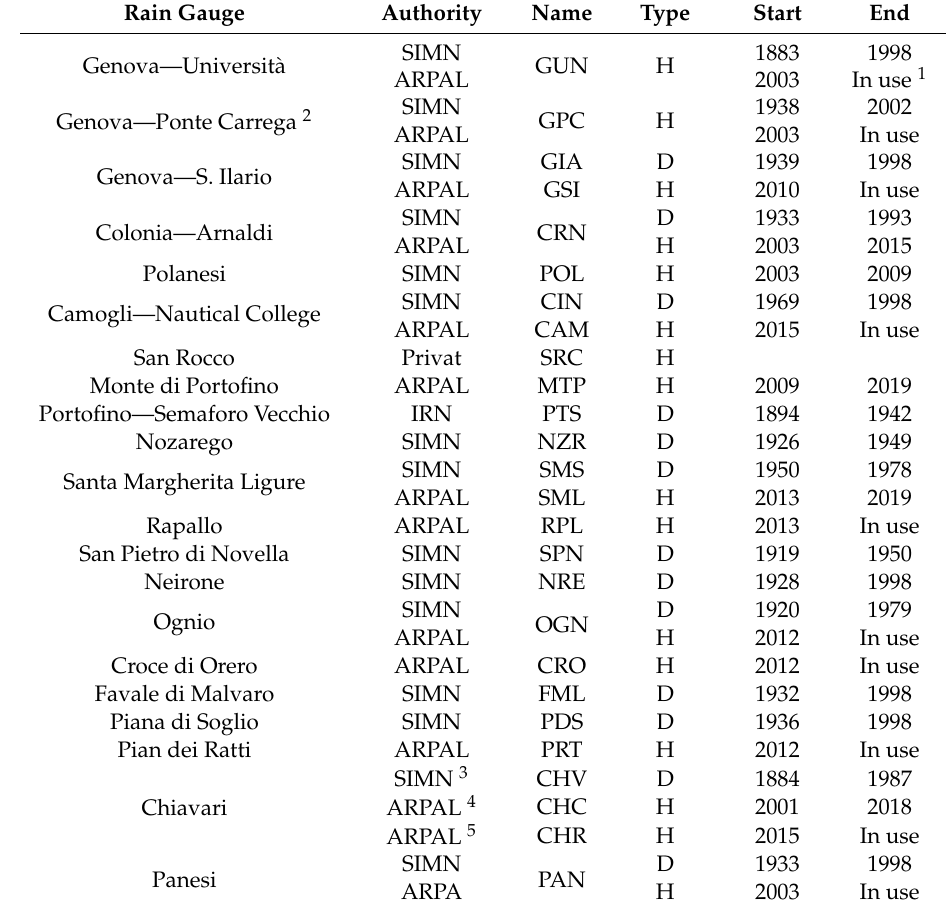
Table 2. Rain gauges used to define rainfall conditions that triggered shallow landslides and debris flows in the Portofino promontory. Type of rainfall data: H, hourly; D, daily. ARPAL = Regional Agency for Environment Protection of Liguria Region; IRN = Italian Royal Navy; SIMN = National Hydrographic and Oceanographic Service. For rain gauge location, see Figure